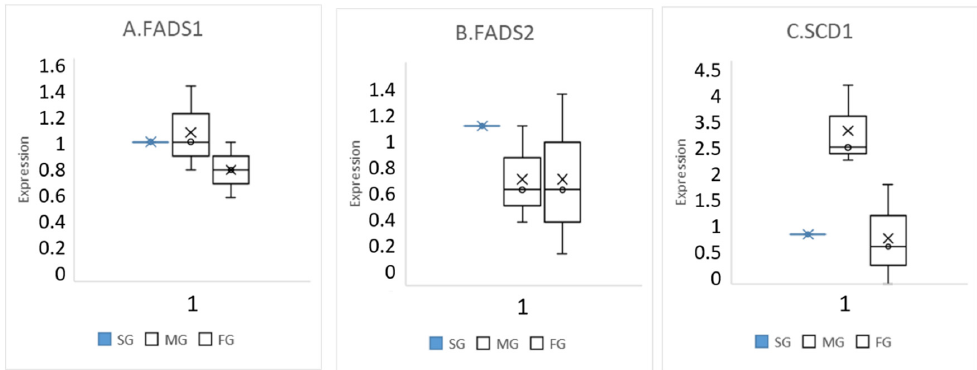
Figure 9. Expression of the genes encoding for the desaturating enzymes in the liver of the three chicken genotypes. ( A ) FADS1, ( B ) FADS2, and ( C ) SCD1 gene expression is reported in the corresponding panel. Data are expressed as median ± range (minimum to maximum). SG: slow growing; MG: medium-growing; and FG: fast growing. Modified by [28].